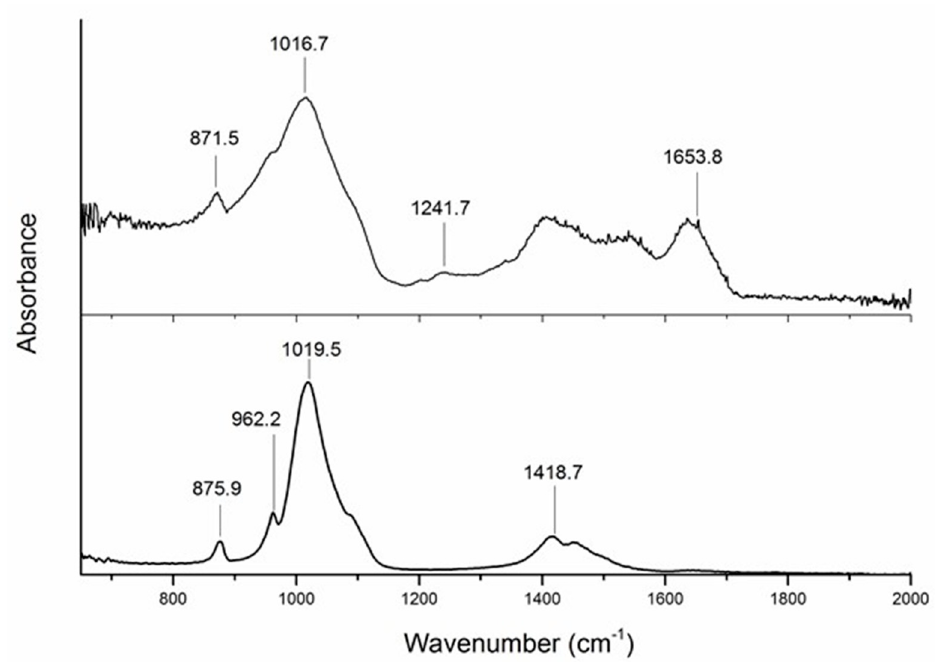
Figure 1. Attenuated Total Reflection Fourier Transform Infrared (ATR-FTIR) spectra of EDEB (top) and anorganic bovine bone (ABB) (bottom). Both plots show peaks corresponding to carbonates and phosphates (871.5 and 1016.7 cm − 1 for EDEB; 875.9, 1418.7, 962.2 and 1019.5 cm − 1 for ABB). Yet, peaks corresponding to amidic bonds of proteins (Amide III, 1241.7 cm − 1 and Amide I, 1653.8 cm − 1 ) can be observed only in the EDEB plot.